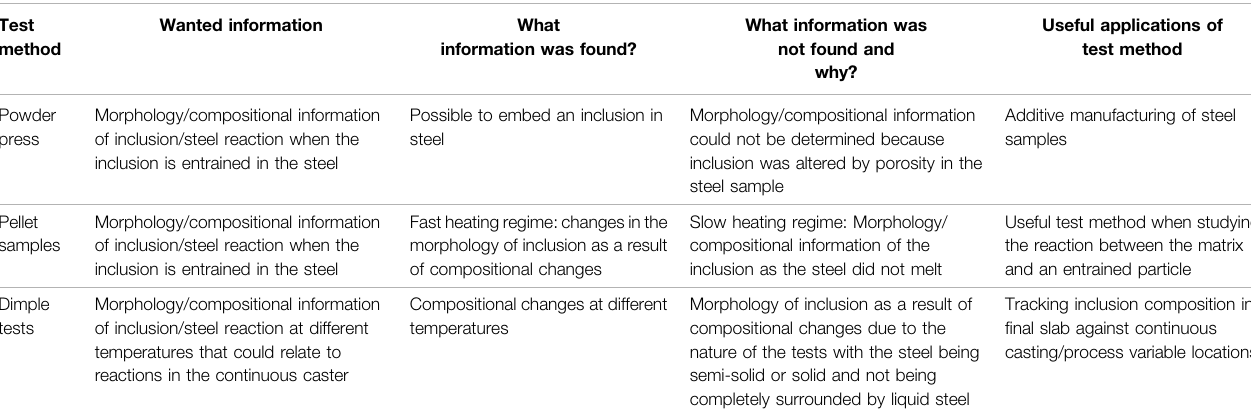
TABLE 6 | Comparison between all the test methods showing the applications, information needed and information that was found and not